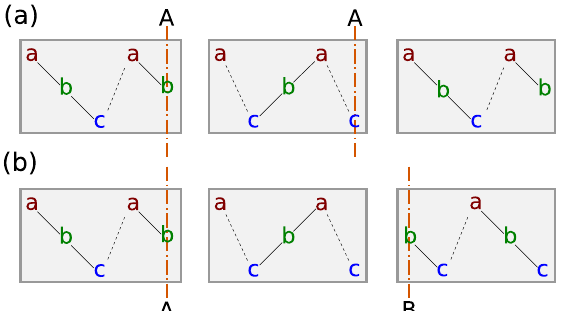
Figure 4. Twin plane orientation. There exist two mutual orientation of TPs. ( a ) TPs are located at the same sides of QLs (similar letters—AA resp. BB). ( b ) TPs occurs at the different sides of QLs (distinct